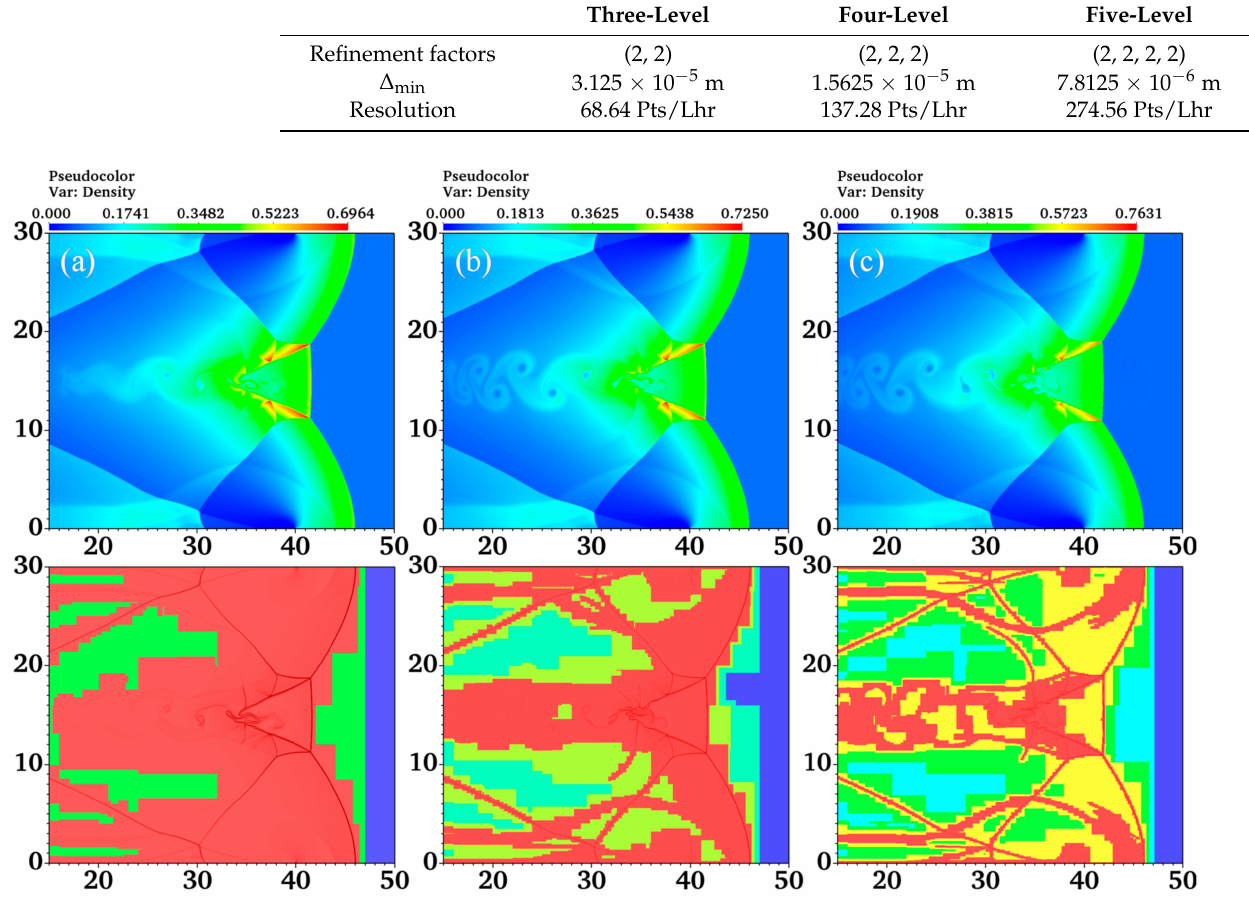
Figure 2. Three adaptive mesh refinement cases: ( a ) Three-level, ( b ) Four-level, and ( c ) Five-level. (Top row: contours of density at 162.5 µ s. Bottom row: refinement effects of three